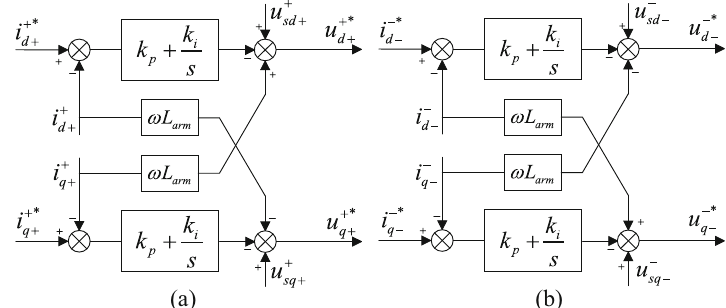
Fig. 6 Voltage asymmetric sag current inner loop control block diagram ( a ) Positive sequence components in forward rotation coordinate system ( b ) Negative sequence component in reverse rotation coordinate system